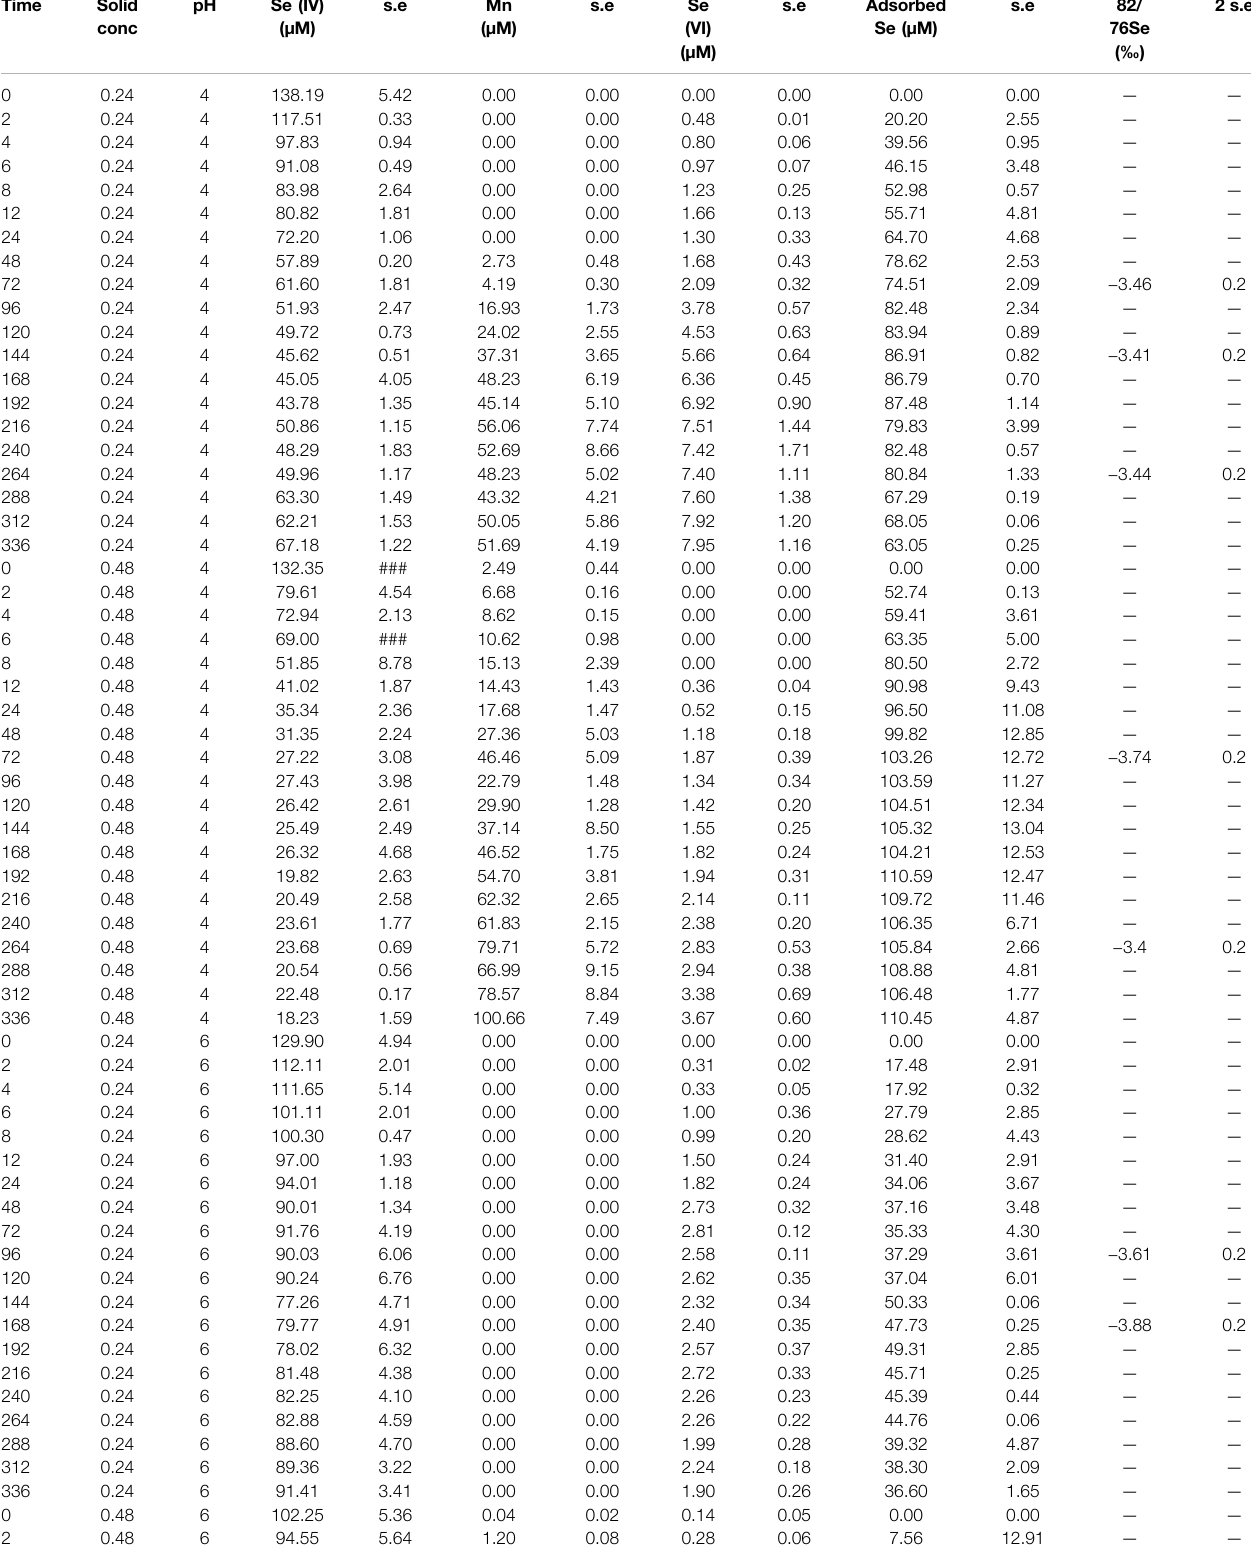
TABLE 3 | Concentration and isotope data for experiments carried out with SG birnessite.